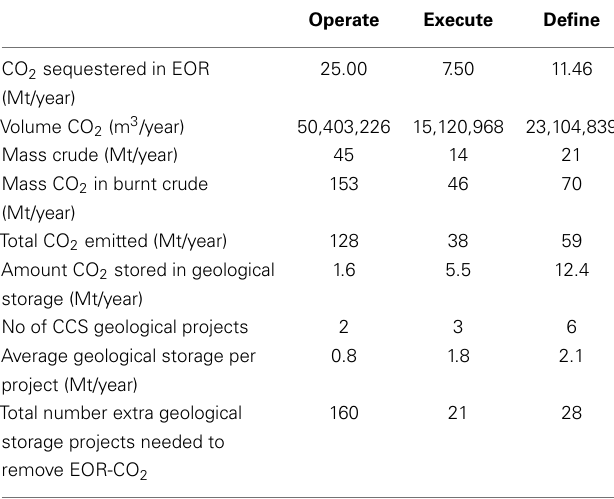
Table 5 |Analysis of CO 2 -EOR projects and further mitigation requirements needed to handle additional CO 2 emissions